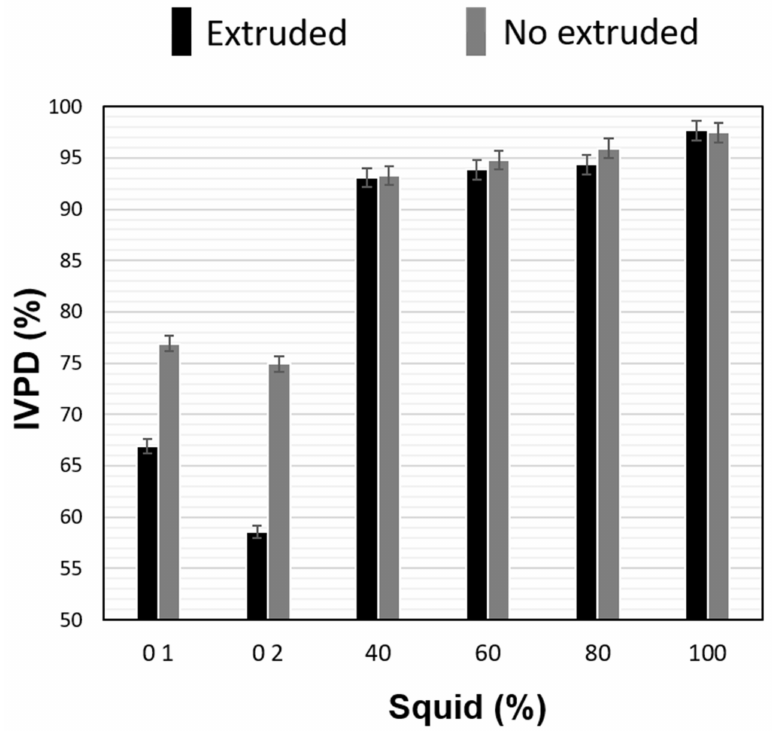
Figure 1. Effect of extrusion process and squid content on in vitro protein digestibility (IVPD) of expanded snacks by extrusion. The bars indicate the standard deviation of 3